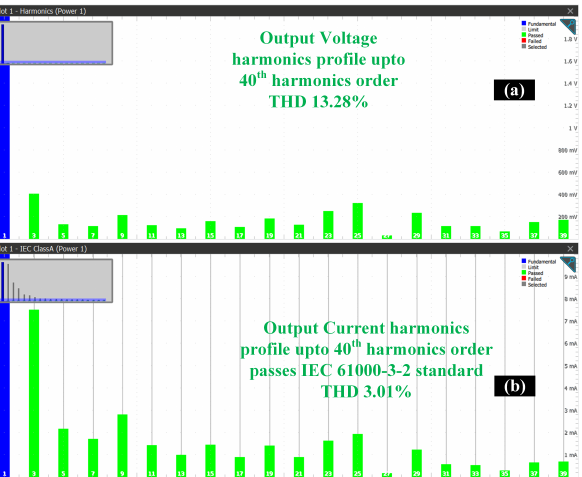
Figure 11. ( a ) Voltage THD using FFT analysis (13.28%), ( b ) Current THD using FFT analysis